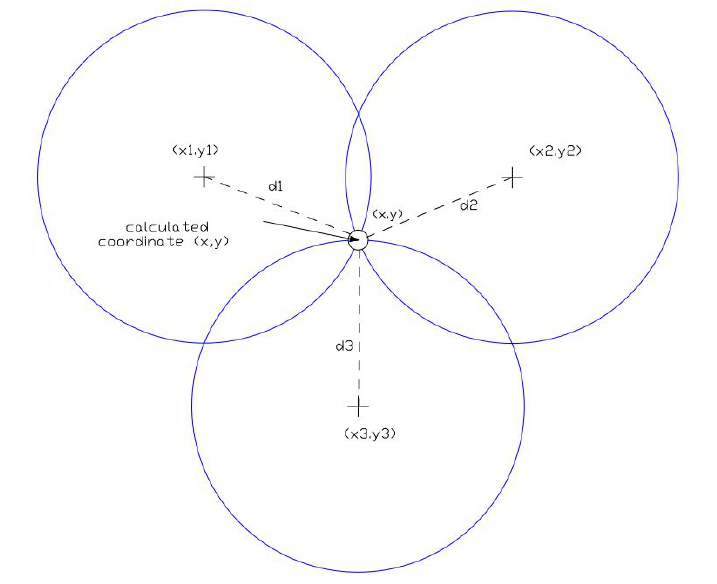
Figure 1. Trilateral positioning